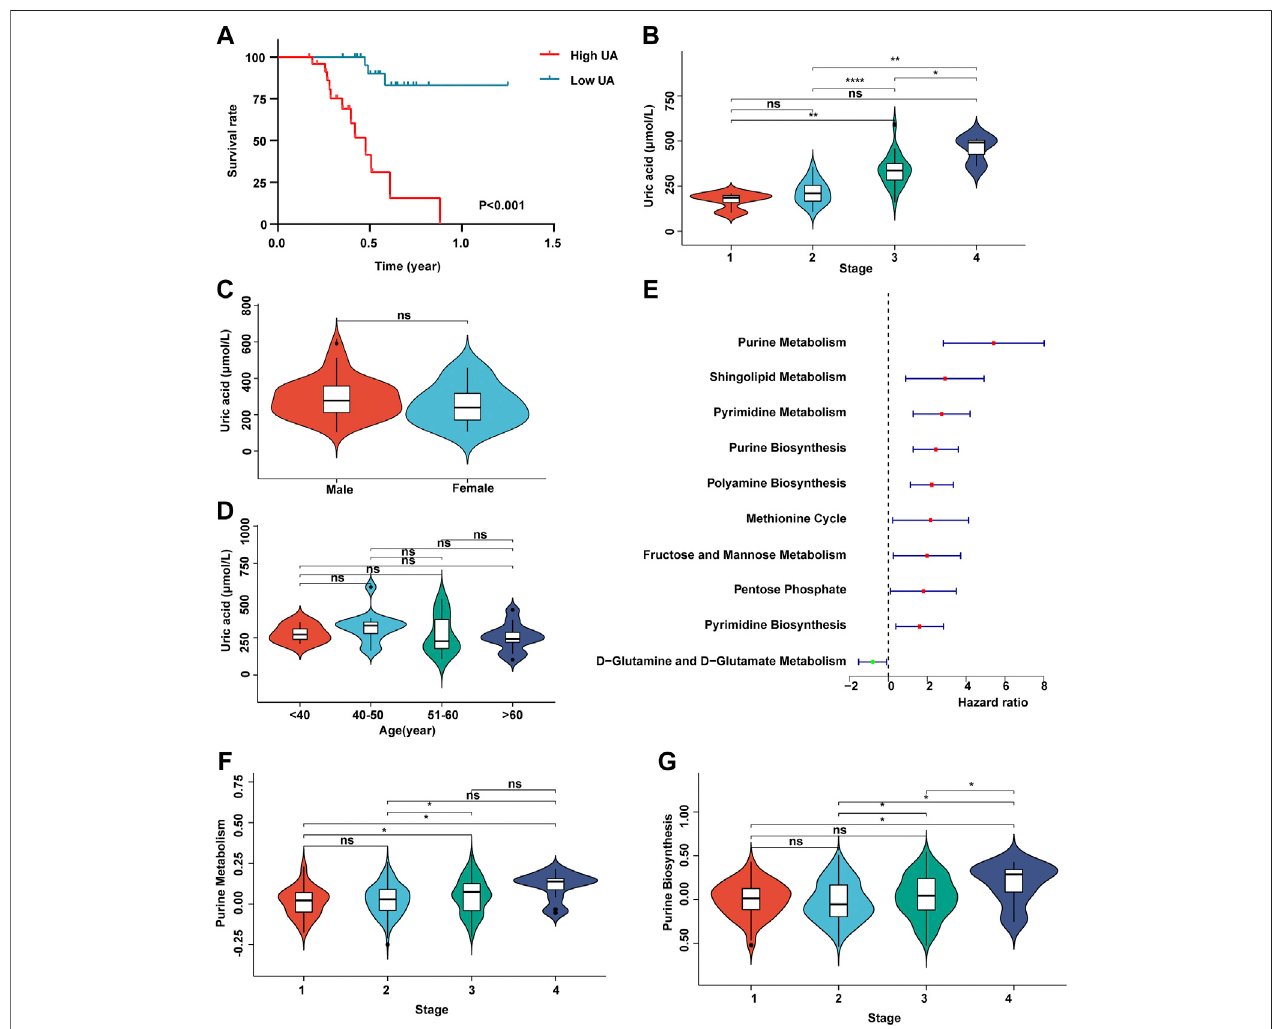
FIGURE1| UricacidwaspositivelycorrelatedwithpoorprognosisinpatientswithHCC. (A) Demonstratetherelationshipbetweenuricacidandsurvivalcurve; (B) content of uric acid in peripheral blood of patients with different stages of HCC; (C) content of uric acid in peripheral blood of patients with HCC in different genders; (D) content of uric acid in peripheral blood of patients with HCC at different ages; (E) forest map shows the relationship between different metabolic pathways and the prognosisofpatients withHCC; (F) purine metabolic pathway activity inpatients withdifferent stages ofHCC; (G) purine synthesis pathway activity inpatientswith different stages of